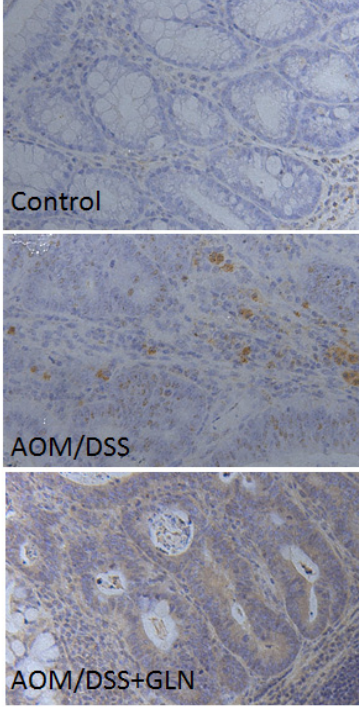
Figure 2. Effect of oral GLN on the expression of DEPTOR in DSS/AOM mice with colitis-associated cancer ( ×200 ). The expression of DEPTOR was found to be increased in DSS/AOM mice treated with GLN.